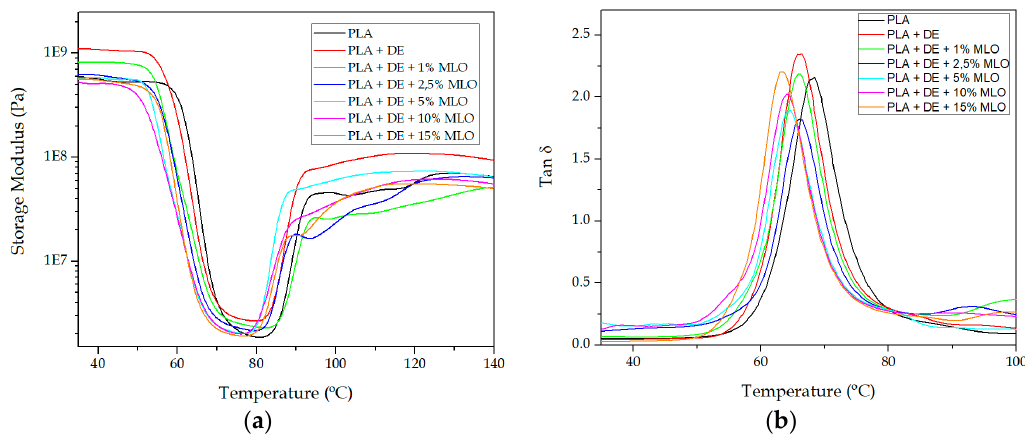
Figure 4. Comparative plot of dynamic mechanical thermal properties of PLA/DE with varying MLO Figure 5. Comparative plot of dynamic mechanical thermal properties of PLA / DE with varying MLO loading as a function of temperature: ( a ) Storage modulus, G ′ and ( b ) dynamic damping factor ( tan loading as a function of temperature: ( a ) Storage modulus, G (cid:48) and ( b ) dynamic damping factor ( tan δ δ ).